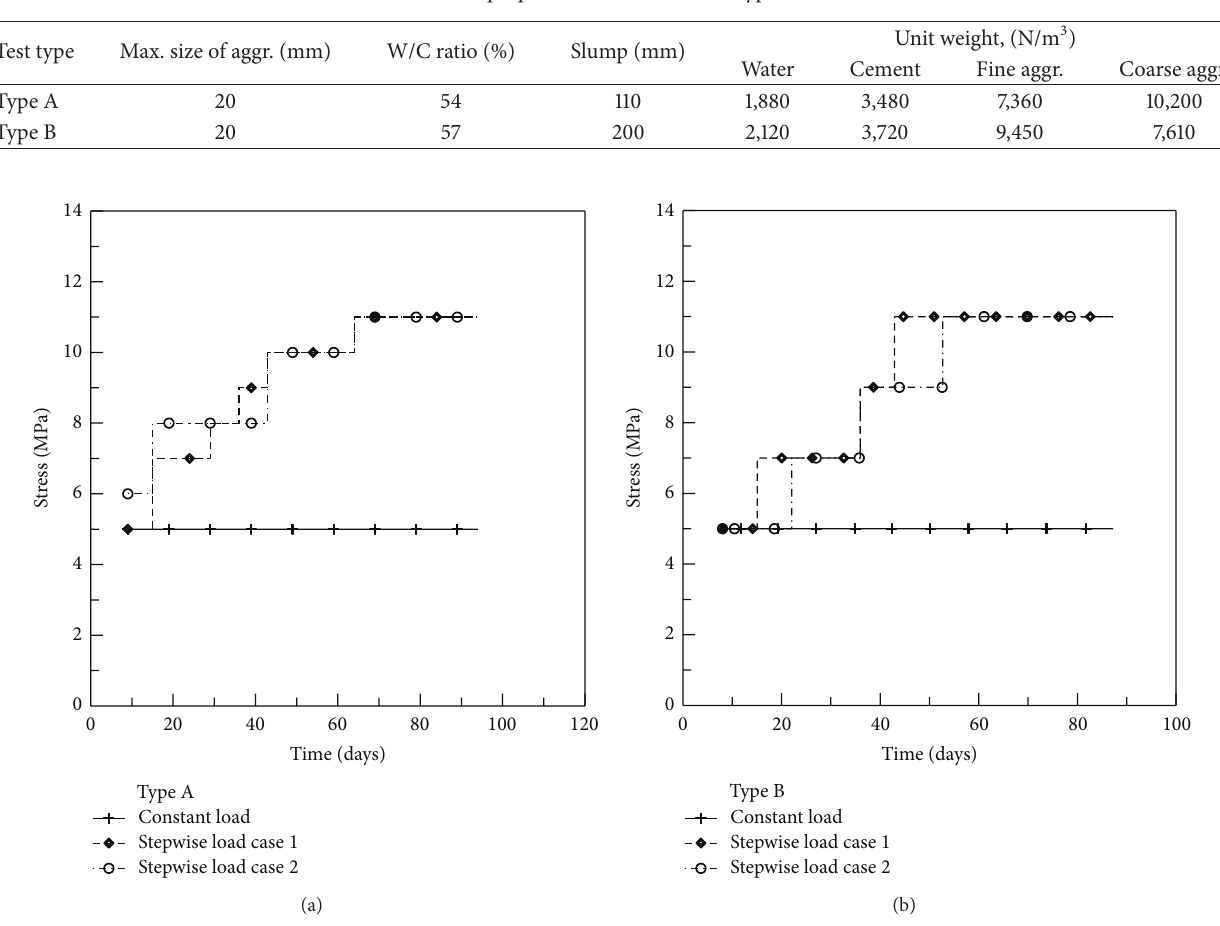
Figure 3: Stepwise loads applied to (a) type A test and (b) type B